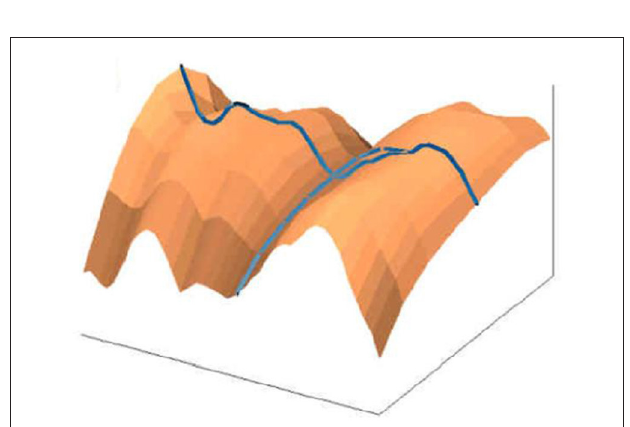
FIGURE 18 | Normalized chromosomal structure detail in chromosomal coordinate system (Jovanovi ´ c, 2001; Jovanovi ´ c et al., 2014).